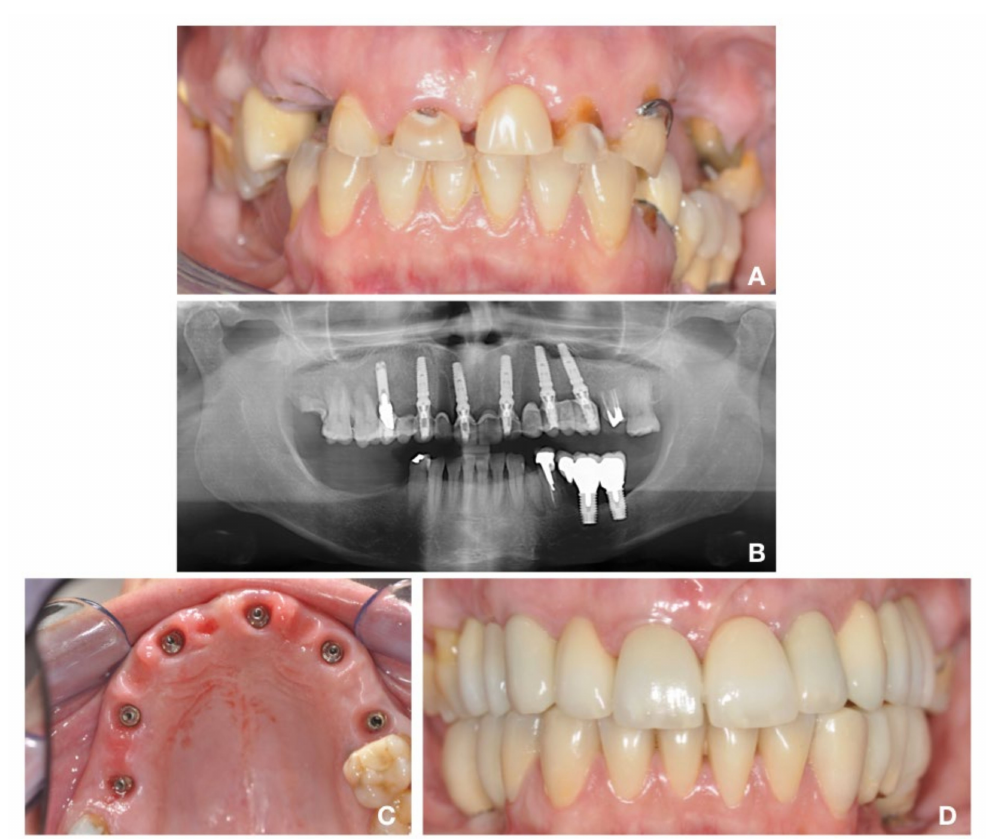
Figure 2. Full arch restoration in fresh extraction sockets, immediately loaded with temporary abutment and prosthesis. ( A ) Clinical situation before teeth extraction. ( B ) Radiographic and ( C ) clinical evaluation after 10 days from implants insertion: soft tissues around the implants did not show signs of inflammation. ( D ) Clinical evaluation after 5 years follow-up: interdental papillae appeared well preserved and no soft tissues retraction